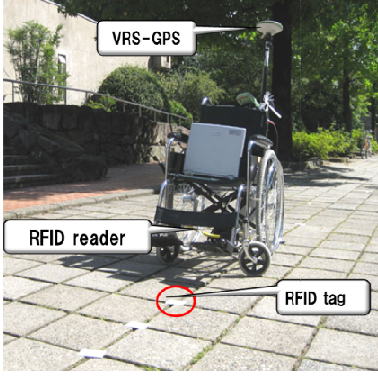
Figure 2. The equipment by experiment